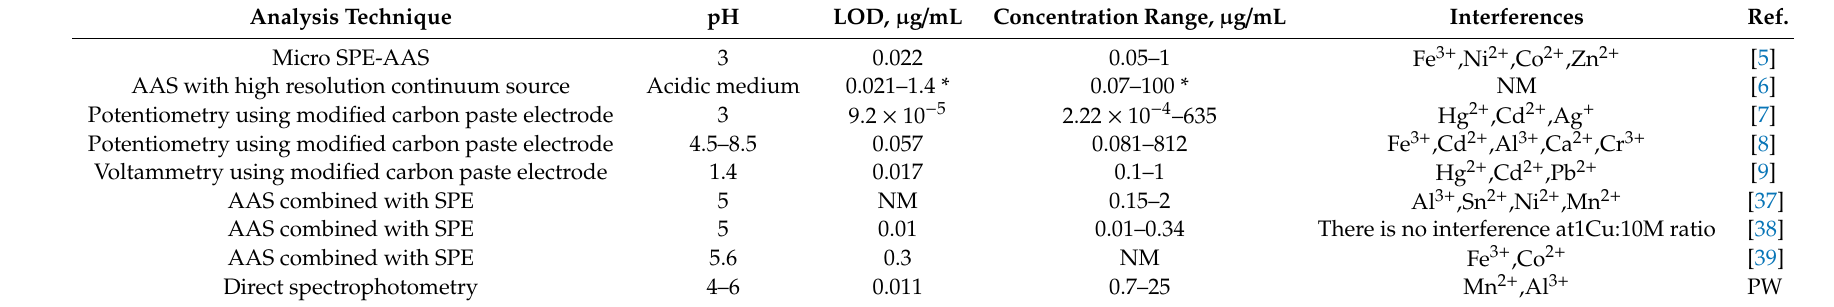
Table 6. Comparison between the proposed method and various previously published analytical techniques to estimate